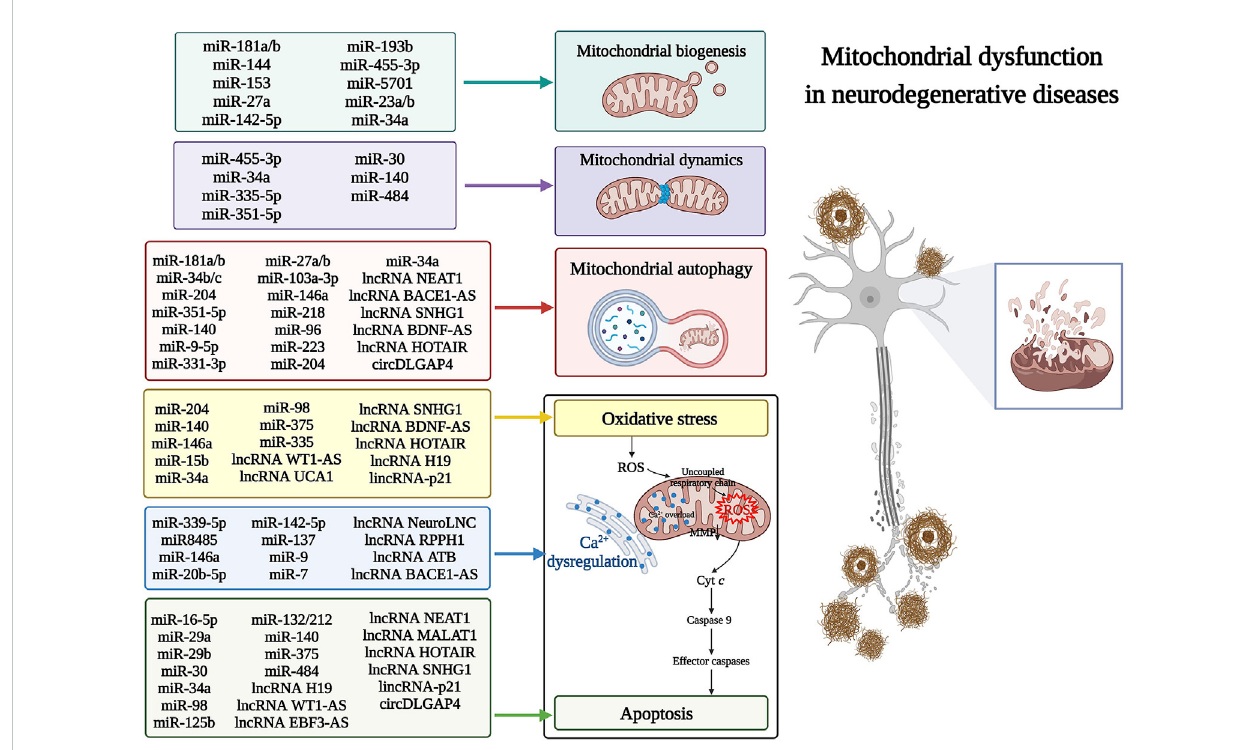
FIGURE 2 The non-coding RNAs (ncRNAs) that regulate mitochondrial dysfunction in neurodegenerative diseases (NDs). Various mitochondrial dysfunctions areassociatedwiththedysregulationofncRNAsinNDs.Thesedysfunctionsincludethepathogenesisofmitochondrialbiogenesis,dynamics,autophagy, calciumdyshomeostasis,reactiveoxygenspecies(ROS)-mediatedmitochondrialoxidativestress,anddownstreamapoptosis.Cyt c ,cytochrome c ;ROS, reactive oxygen species; MMP, mitochondrial membrane